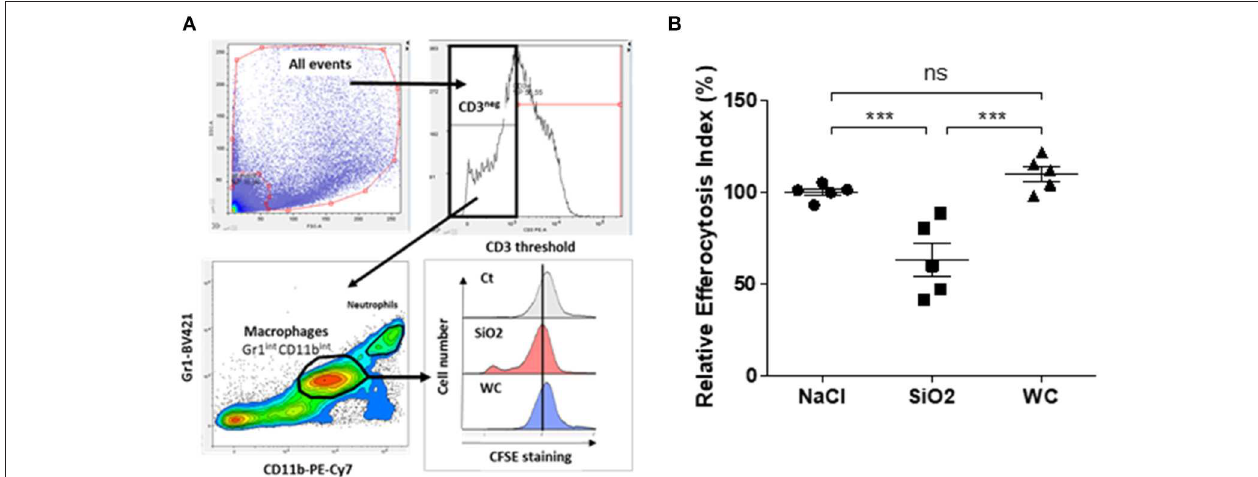
FIGURE 3 | Impaired efferocytosis capacities of alveolar M 8 from mice exposed in vivo to SiO 2 . (A) Gating strategy used to evaluate efferocytosis capacities of alveolar M 8 from mice. EI of BAL cells obtained from mice exposed to NaCl or to 1.5mg of SiO 2 or WC for 4 days and then exposed in vivo to CFSE pos apoptotic Jurkat (apoJ) cells, were analyzed by flow cytometry. (B) EI of alveolar M 8 which have engulfed apoptotic CFSE pos Jurkat cells (CD3 neg Gr1 int CD11b int CFSE pos cells). Efferocytosis of mice treated with NaCl as control was set as 100% ( n = 5 mice in each group). *** p < 0.001; ns, not significant.